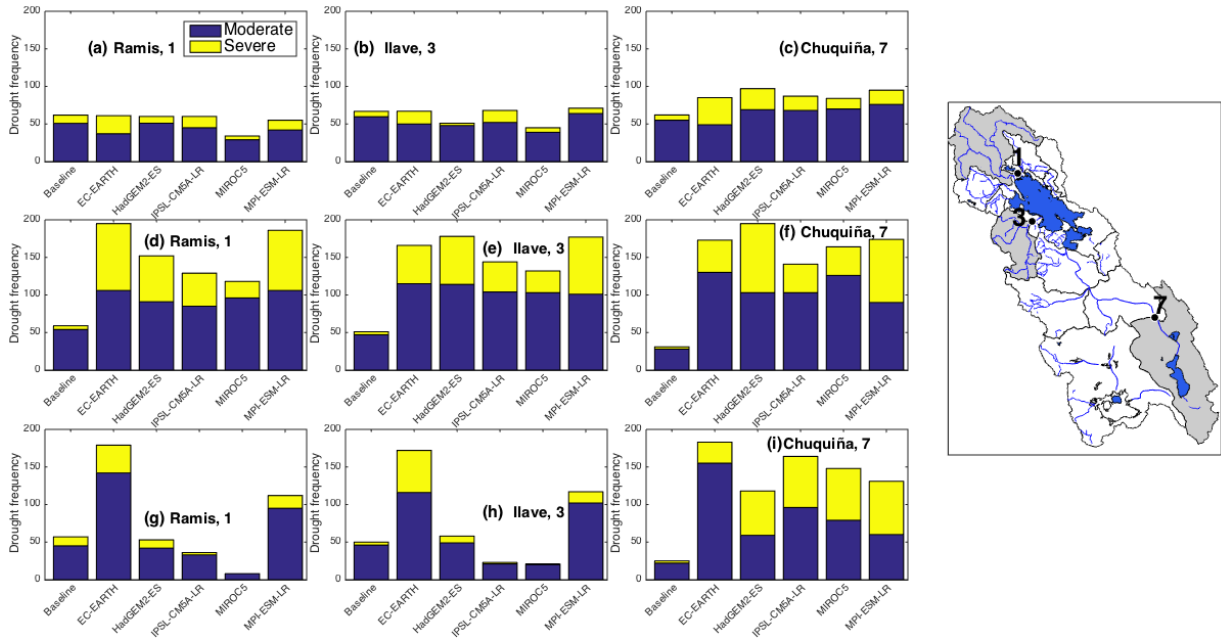
Figure 12. Total number of drought months (frequency, y -axis) of meteorological ( a – c ), agricultural ( d – f ), and hydrological ( g – i ) droughts for the future period (2034–2064) in comparison to the baseline period (1984–2014). Results for five future GCM scenarios for three selected sub-basins controlled at the Ramis (1), Ilave (3), and Chuquiña (7) stations are shown. Numbers in parentheses indicate the location of the control points in the map.